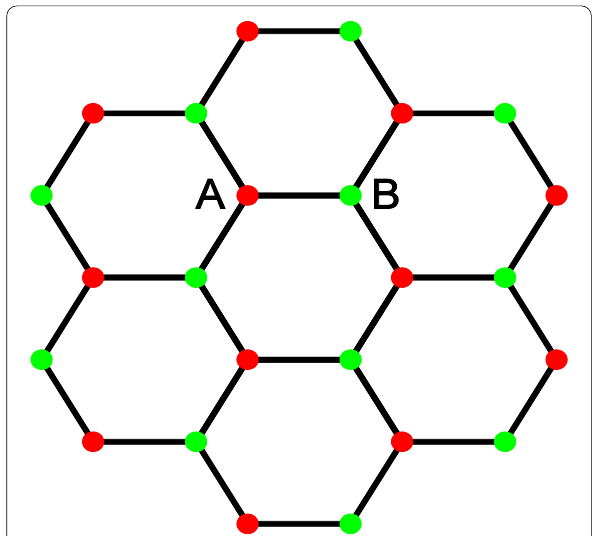
Fig. 1 (Color online): The honeycomb lattice, where A and B label two different sites of the